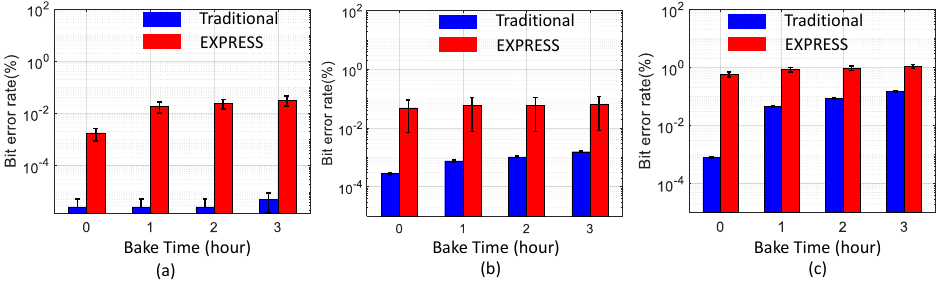
Figure 13. BER as a function of retention loss for traditional programming (blue) and proposed partial programming (red) for ( a ) SLC, ( b ) LSB, and ( c ) MSB pages.